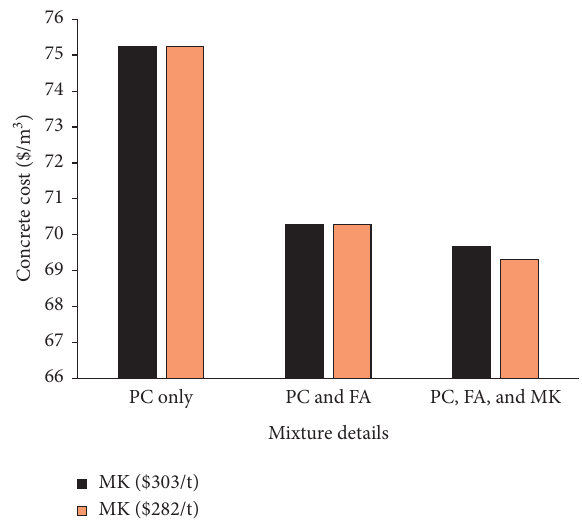
Figure 3: Cost summary for producing MK concrete